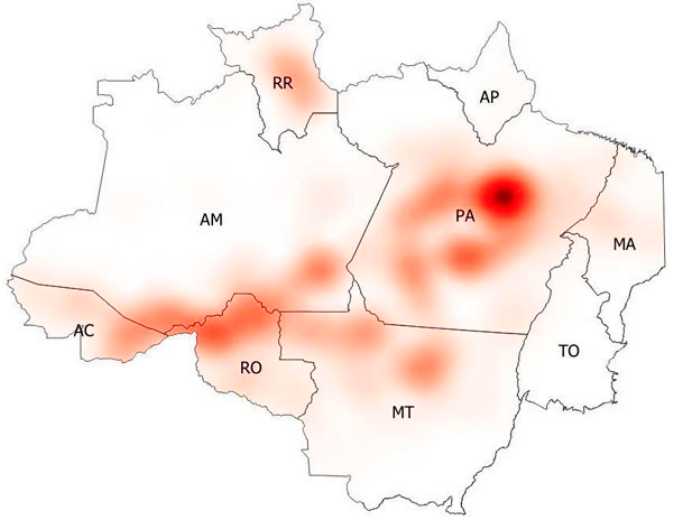
Figure 8. Heat map of deforestation occurrences identified in PRODES 2019, in the 229 scenes that make up the Brazilian Amazon. Source: INPE (2020), PRODES (2020).